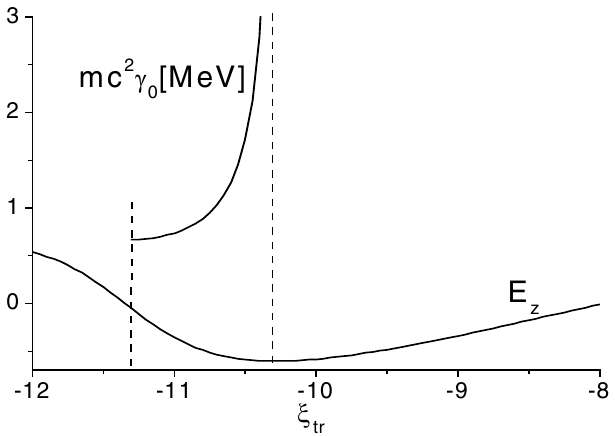
FIG. 3. Initial energy of the trapped electron (in MeVs) and the normalized accelerating field E dependence on the trapping point in the wave, a (cid:2) 2 . The trapping region is shown between dashed 50 , and (cid:31) z lines.